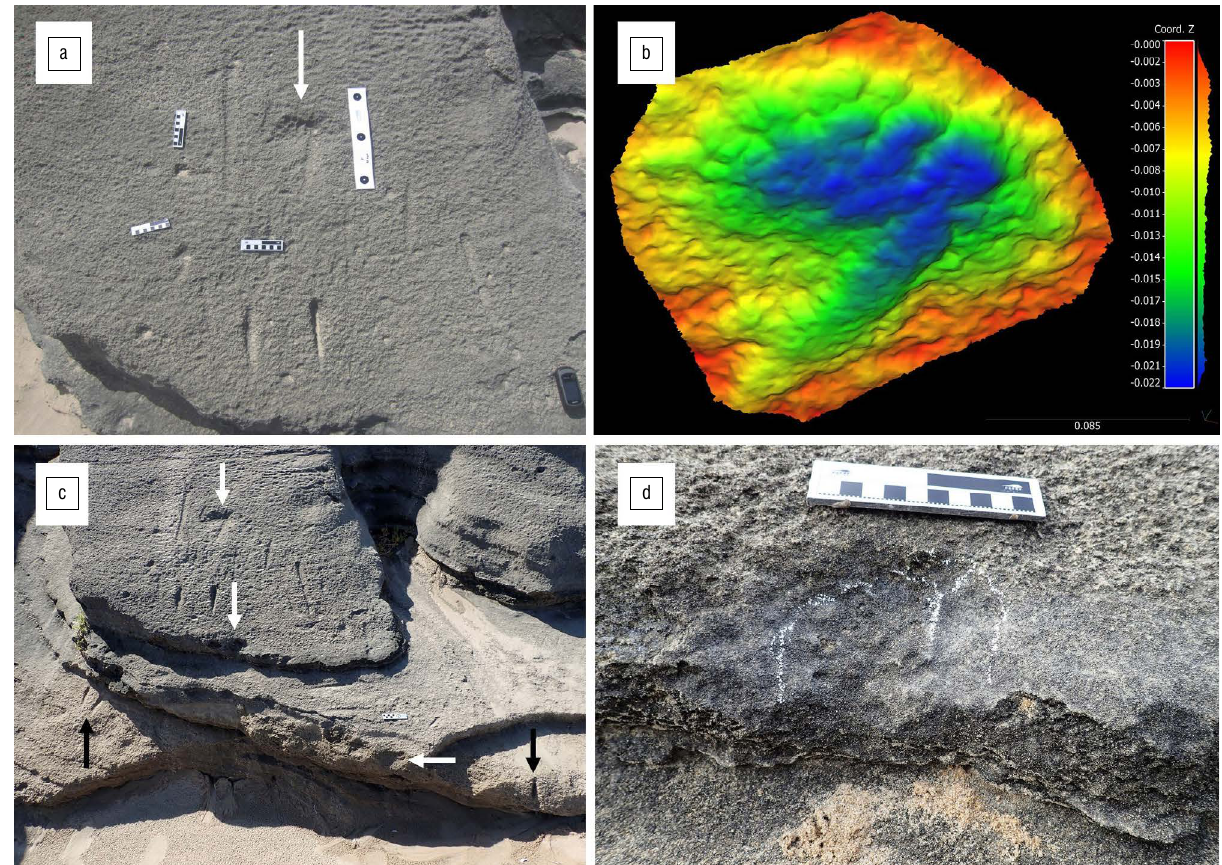
Figure 9: (a) The originally documented surface of Site 3, with central putative forefoot impression (indicated by arrow) and surrounding groove features; scale bars = 10 cm and 25 cm. (b) Photogrammetry colour mesh: tight tilt view of putative footprint on main surface of Site 3, using 27 images. Photos were taken an average of 0.466 m from the surface. The reprojection error is 0.243 pix. Vertical and horizontal scales are in metres. (c) Site 3 after extensive scouring by wave action; white arrows indicate the three probable partial human tracks; black arrows indicate newly exposed groove features; scale bar = 10 cm. (d) Newly identified probable partial human track, lightly outlined in white chalk; scale bar = 10 cm; this track is indicated by the middle white arrow in